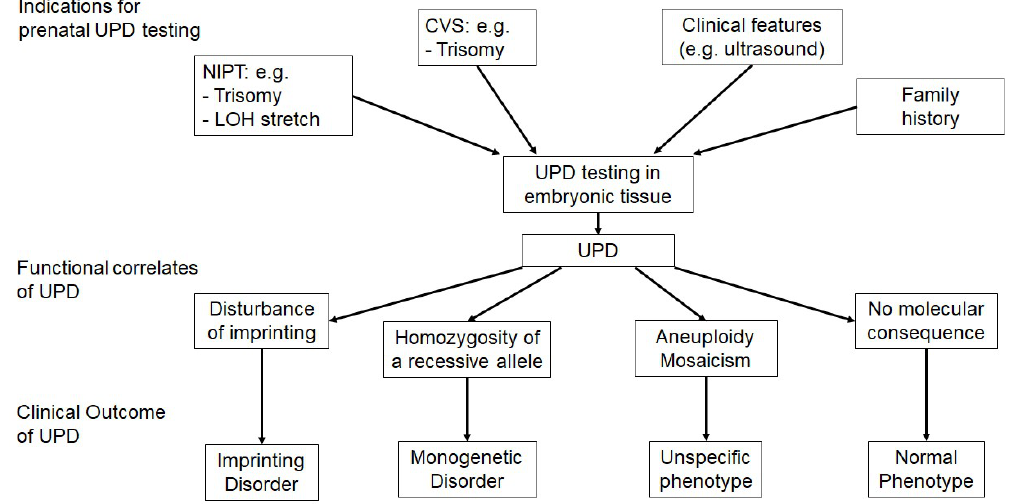
Figure 2. Overview on the indications for uniparental disomy (UPD) testing, the functional correlates and clinical outcomes of UPD, (NIPT—non-invasive prenatal testing, LOH—loss of heterozygosity, CVS—chorionic villous sampling).